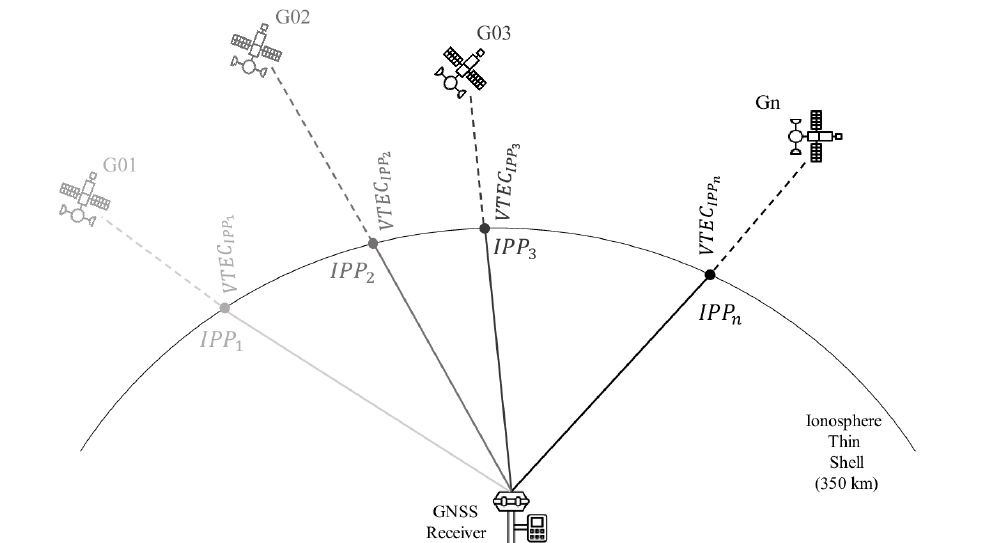
Figure 1. VTEC variations per individual PRN, at a specific time epoch. IPP points are the intersections of GNSS signal in the ionosphere assuming the theory of single layer model (SLM). Based on the assumption that adjacent points share the same ionosphere conditions, our model investigates GNSS method’s efficiency in providing TEC